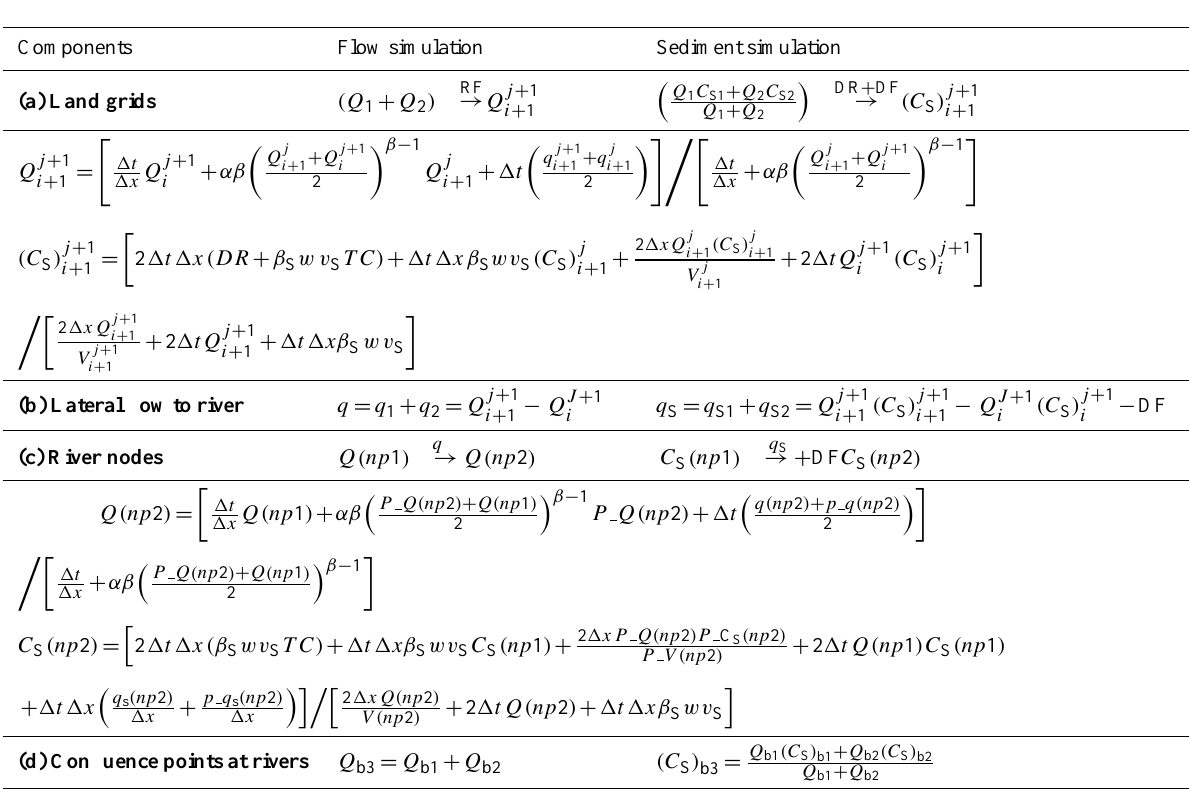
Table 3. Solution approaches for flow and sediment transport in distributed areas (as described in Fig. 4).